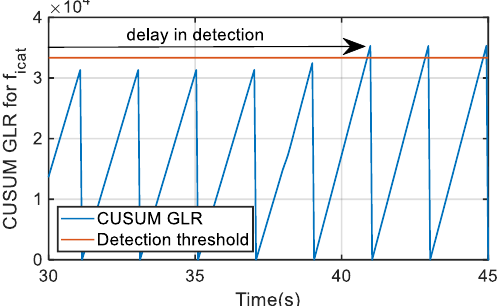
Figure 16. CUSUM GLR calculation for a critical o ff set fault injection in catenary current Figure 16 . CUSUM GLR calculation for a critical offset fault injection in catenary current sensor.